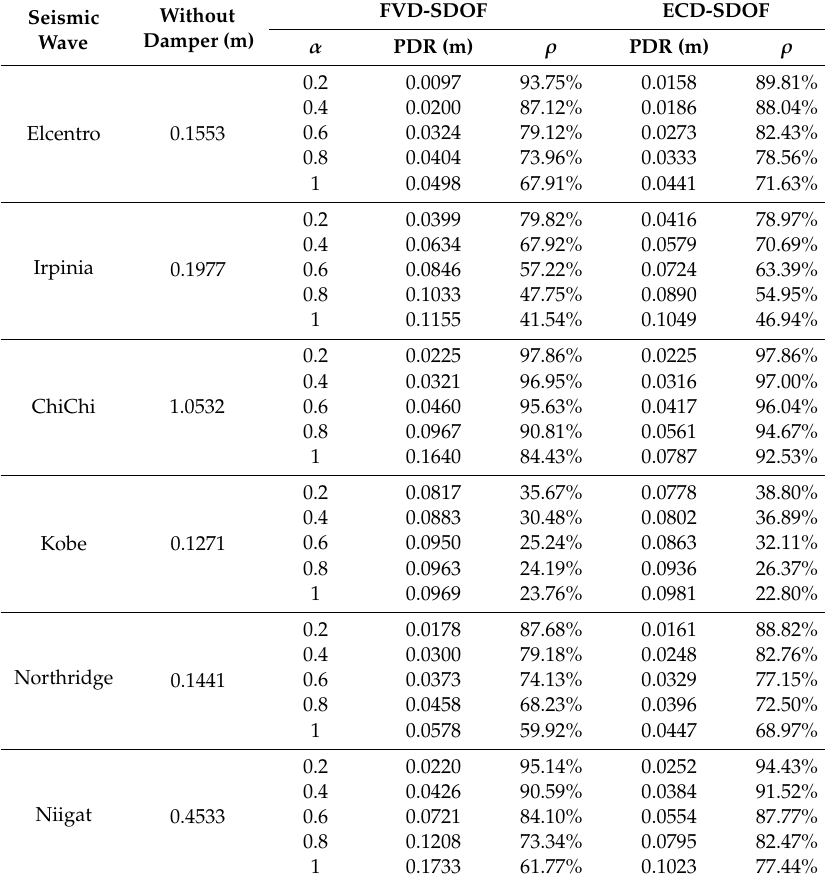
Table 1. Peak displacement responses (PDRs) of SDOF-ECDs and SDOF-FVDs. Seismic